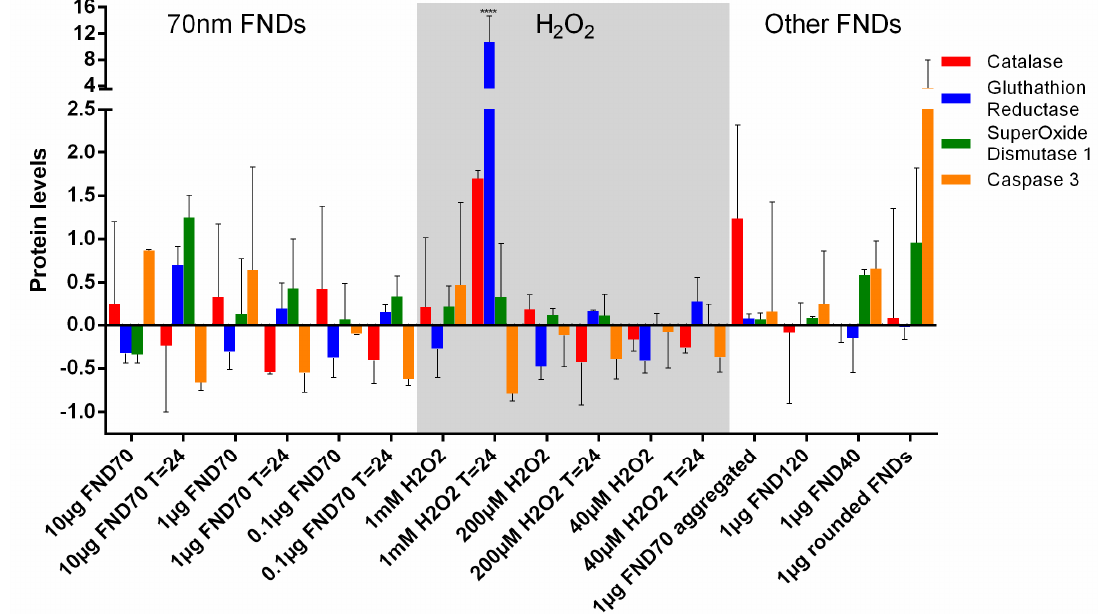
Figure 6. Levels of oxidative stress-related proteins. By quantitating Western Blots, protein levels as a response to the uptake of diamonds or the presence of H 2 O 2 have been analysed. The control is set as 1, the protein levels are shown as fold increase or decrease for all samples. The protein levels after uptake of 40, 70 and 120 nanometre FNDs did not differ significantly from the control situation. Note that although in cells with rounded FNDs the caspase-3 levels are increased, this is not significant. **** p < 0.0001. Error bars show the standard deviations. The values are averages out of 3 independent Western Blots of samples in triplicate.